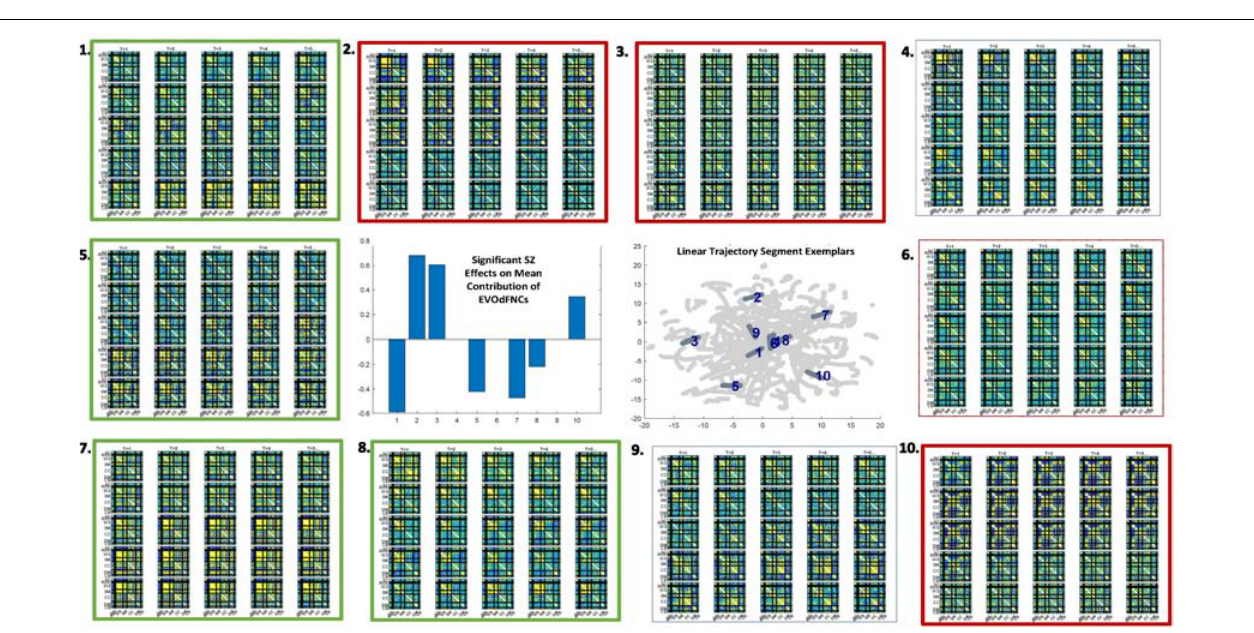
FIGURE 10 | Zooming in on a box within the display (transparent background) of local linearizations of embedded curves (LTSs) colored according to the 2D linear trajectory exemplar cluster to which they belong. Within the same region, the individual LTSs can belong to different exemplar clusters based on slope.